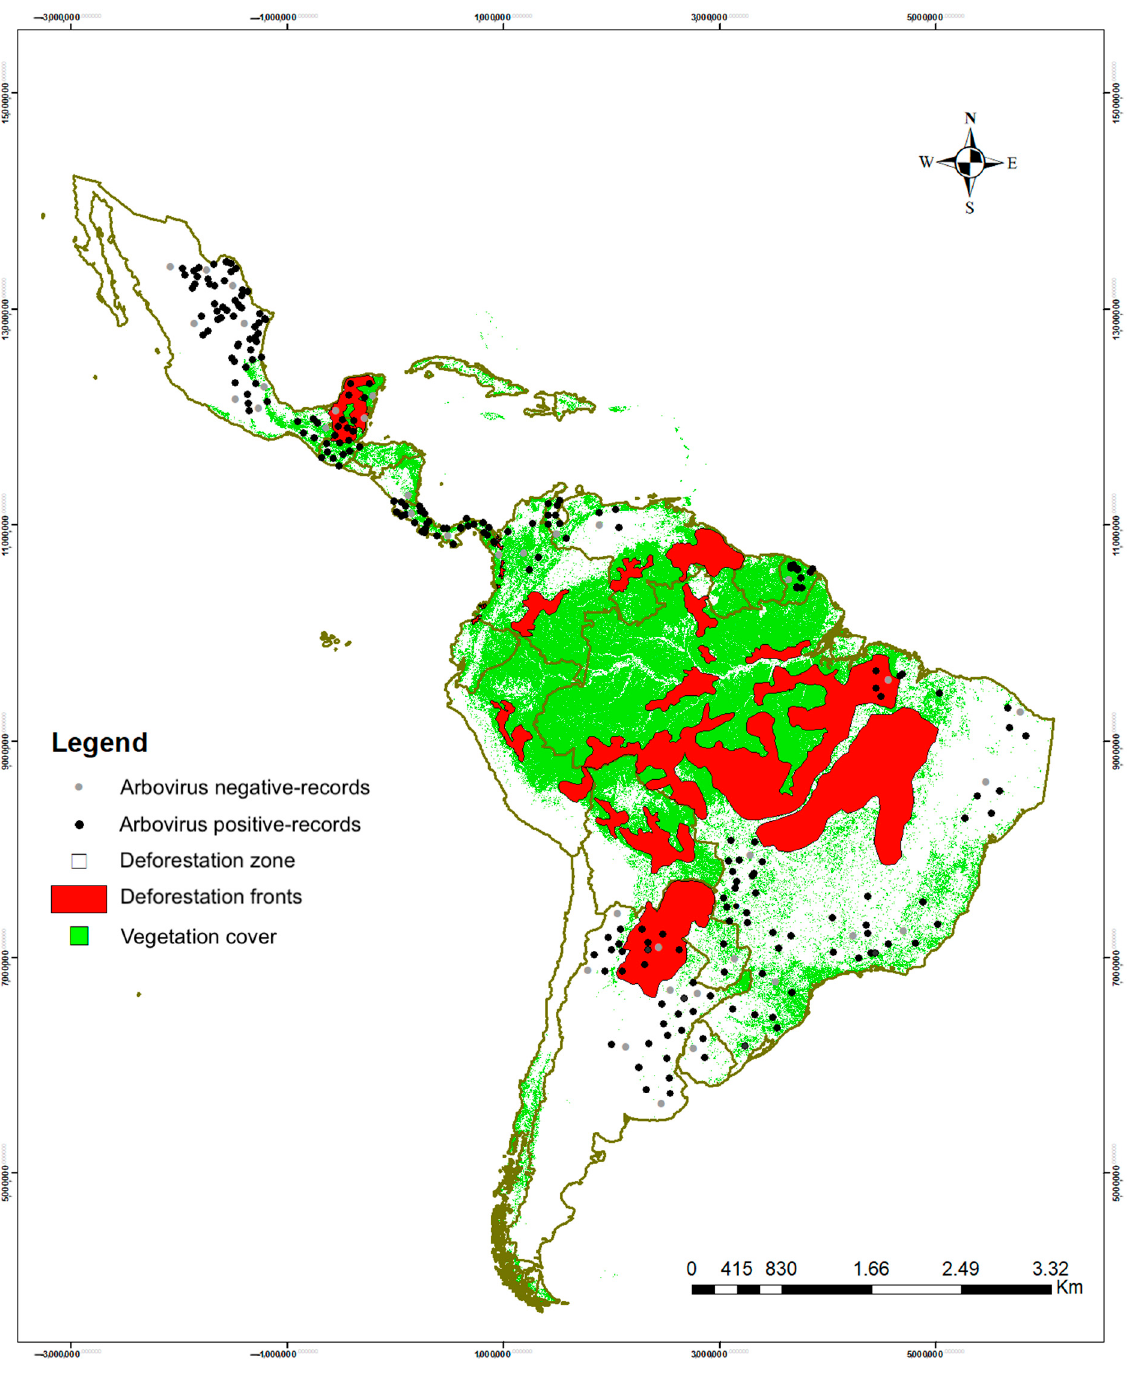
Figure 9. Representation of arbovirus positive and negative records, vegetation cover, and defor- ested fronts in the Neotropics. fronts in the